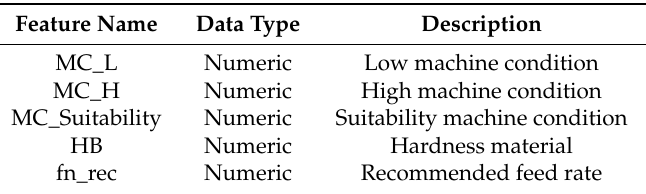
Table 2. Cutting velocity dataset–feature